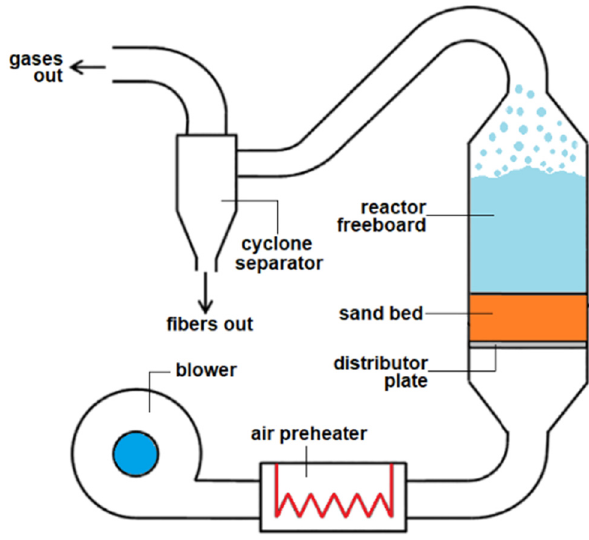
Figure 16: Simple schematic of FB CFRP waste recycling reactor [ 87 ]